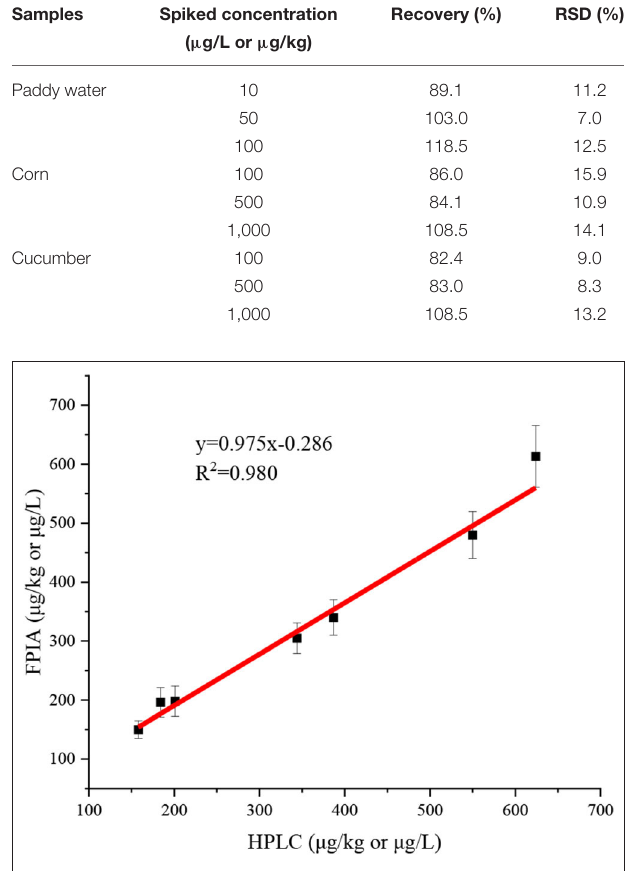
FIGURE 3 | Correlation between FPIA and HPLC for the concentrations of IMI in authentic